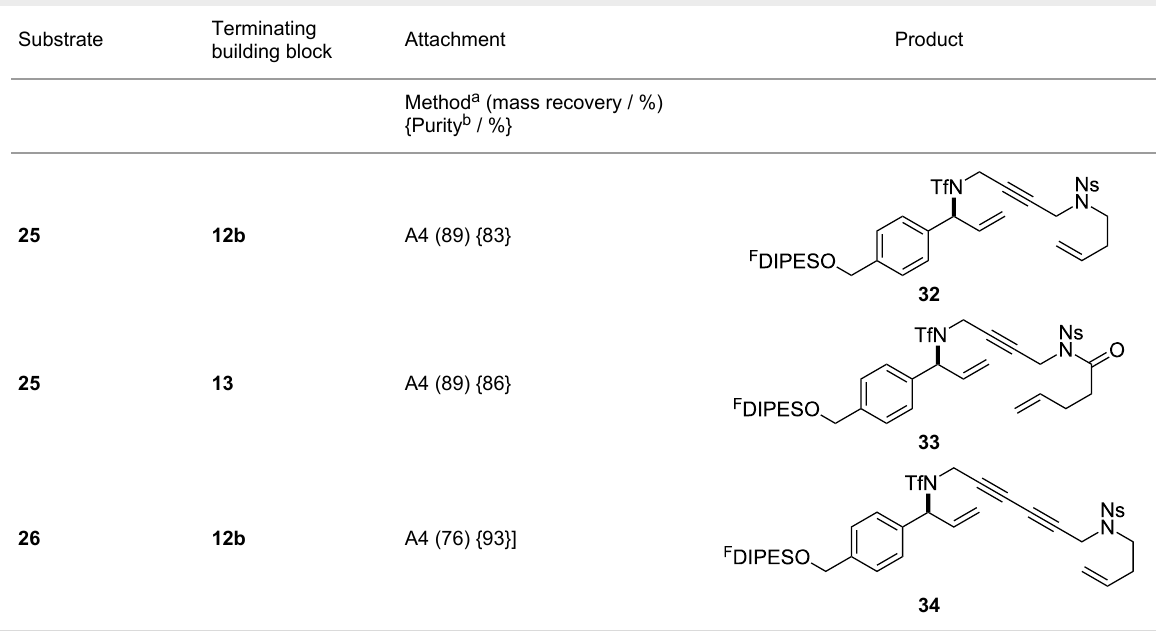
Table 2: Attachment of propagating building blocks to the fluorous-tagged initiating building blocks.